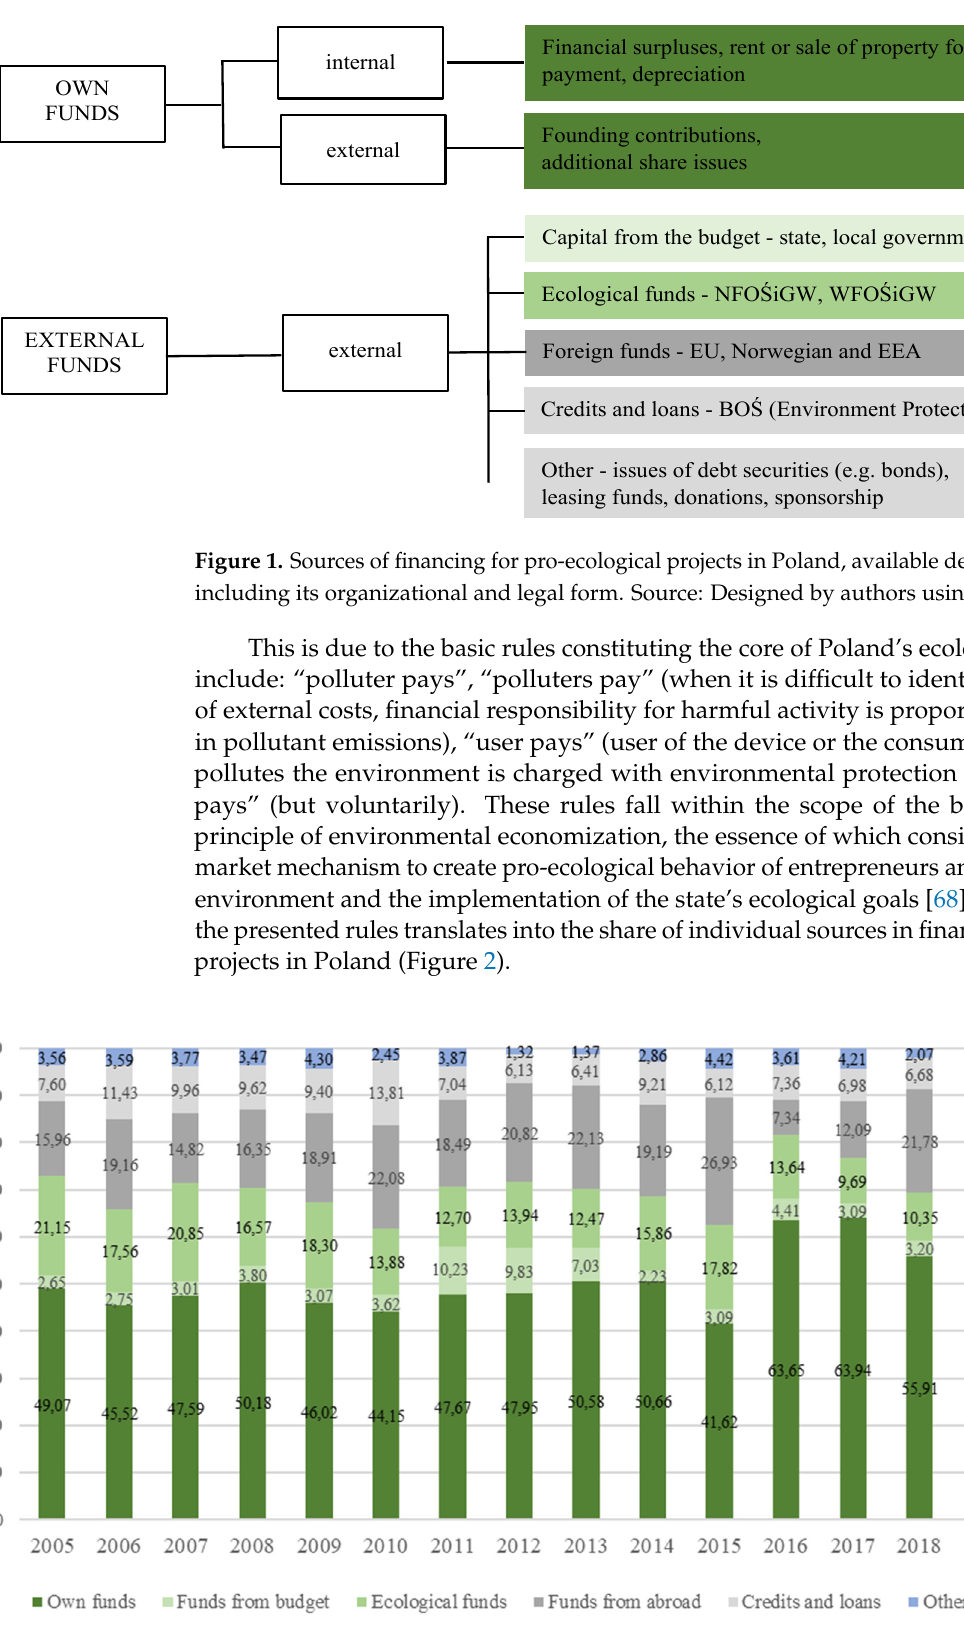
Figure 2. Share of financing sources for pro-ecological projects in Poland in 2005–2020. Source: designed by authors using [51].